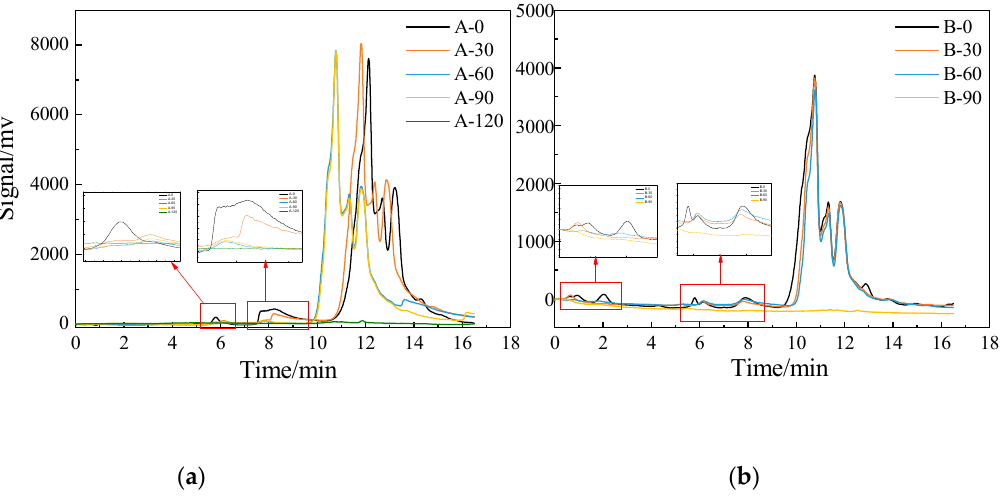
Figure 9. The distribution and changes of molecular weight of DOMs during the degradation. ( a ) and ( b ) are the changes in molecular weight of DOMs in SE-A and SE-B, respectively. Table 3. The relationship between peak time and molecular